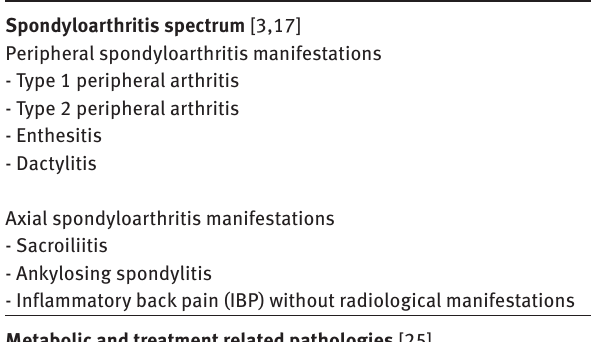
Table 1: Clinical musculoskeletal manifestations of inflammatory bowel